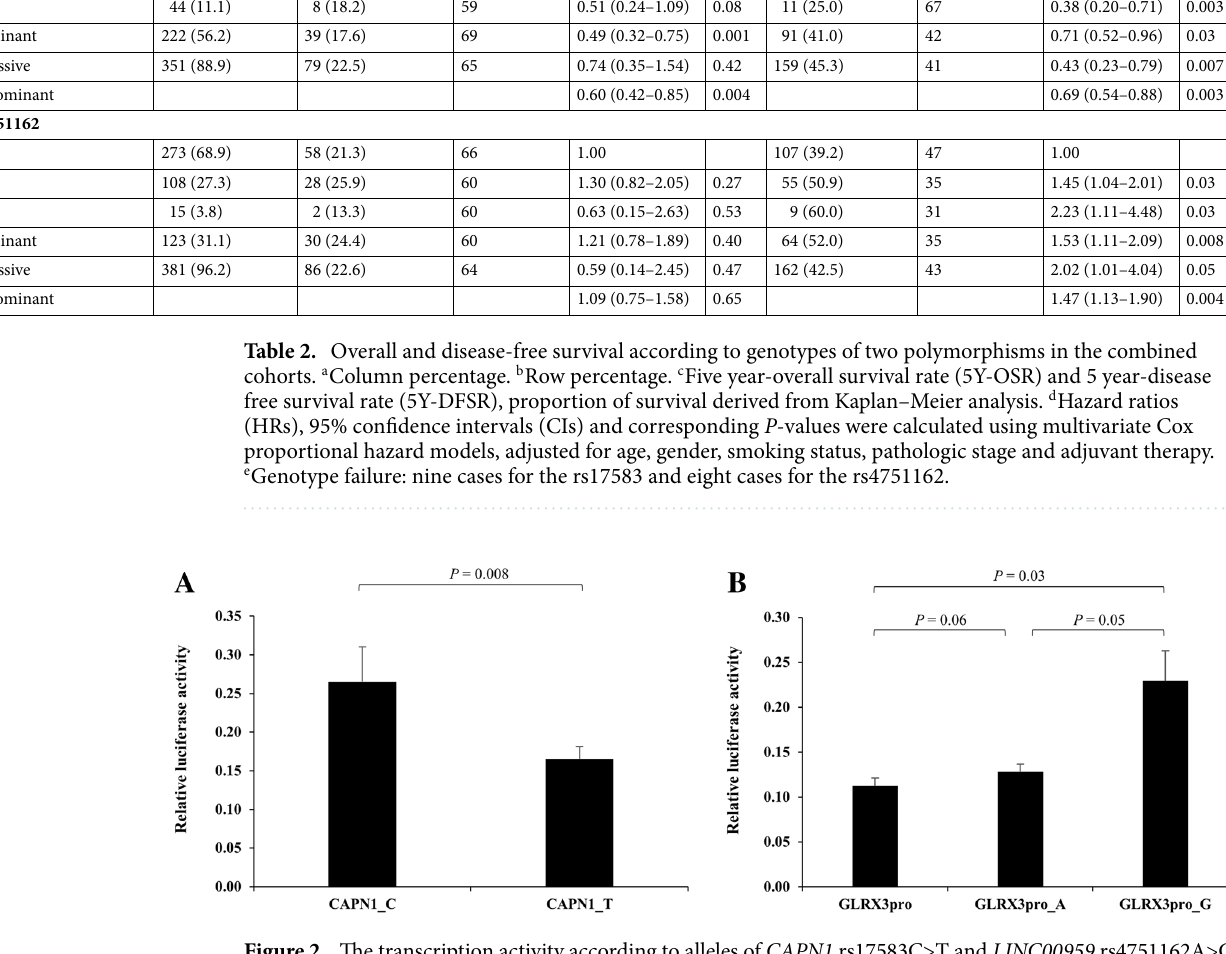
Figure 2. The transcription activity according to alleles of CAPN1 rs17583C>T and LINC00959 rs4751162A>G measured by luciferase reporter assay. The H1703 cells were transfected with pGL3- CAPN1 _C and pGL3- CAPN1 _T for rs17583 ( A ), and pGL3- GLRX3 pro, pGL3- GLRX3 pro_A, or pGL3- GLRX3 pro_G for rs4751162 ( B ), respectively. The data were analyzed using Excel. Each bar represents mean ± SEM of luciferase activity normalized to Renilla luciferase activity. Experiments were performed in triplicate. P value, Student’s